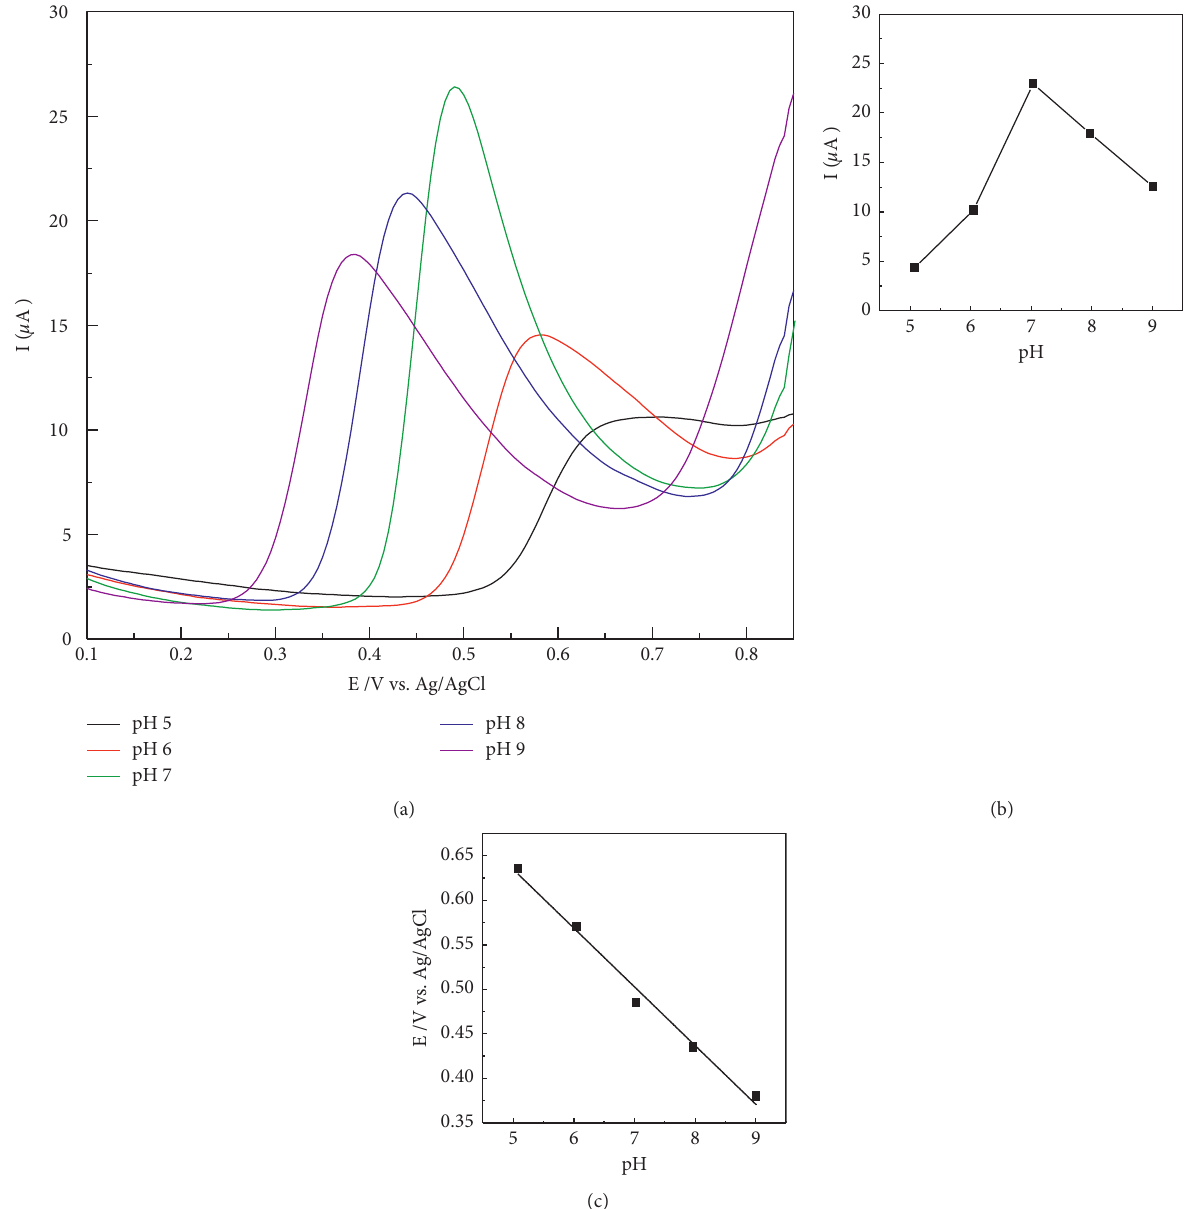
Figure 5: DPVs of 50 µ m BPA on AuNDs/CTAB/GCE in PBS pH 7 with different pH: 5.0; 6.0; 7.0; 8.0, and 9.0 (a). Currents varied by pH (b) and relationship between potentials and pH